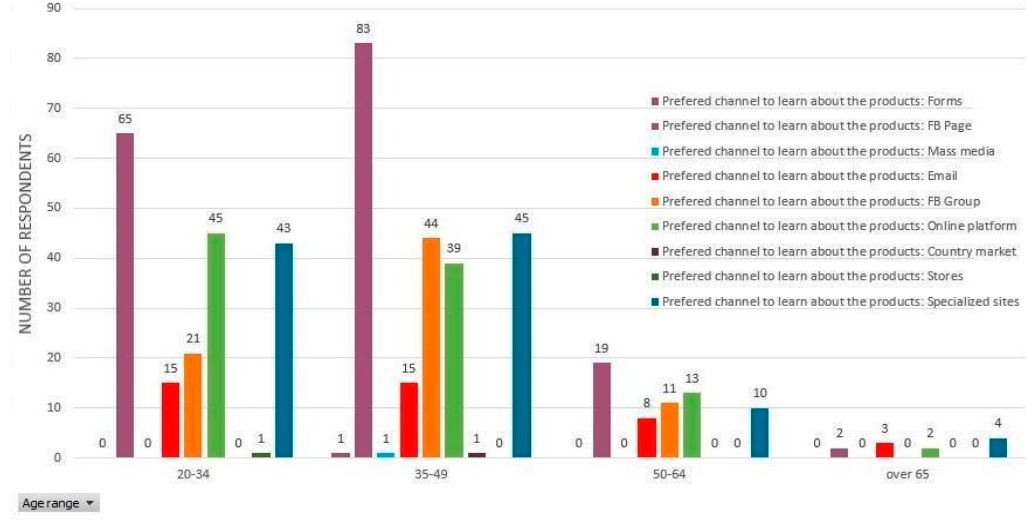
Figure 11. The distribution of answers according to favorite channels of information regarding fresh vegetables, depending on the respondents’ age groups.